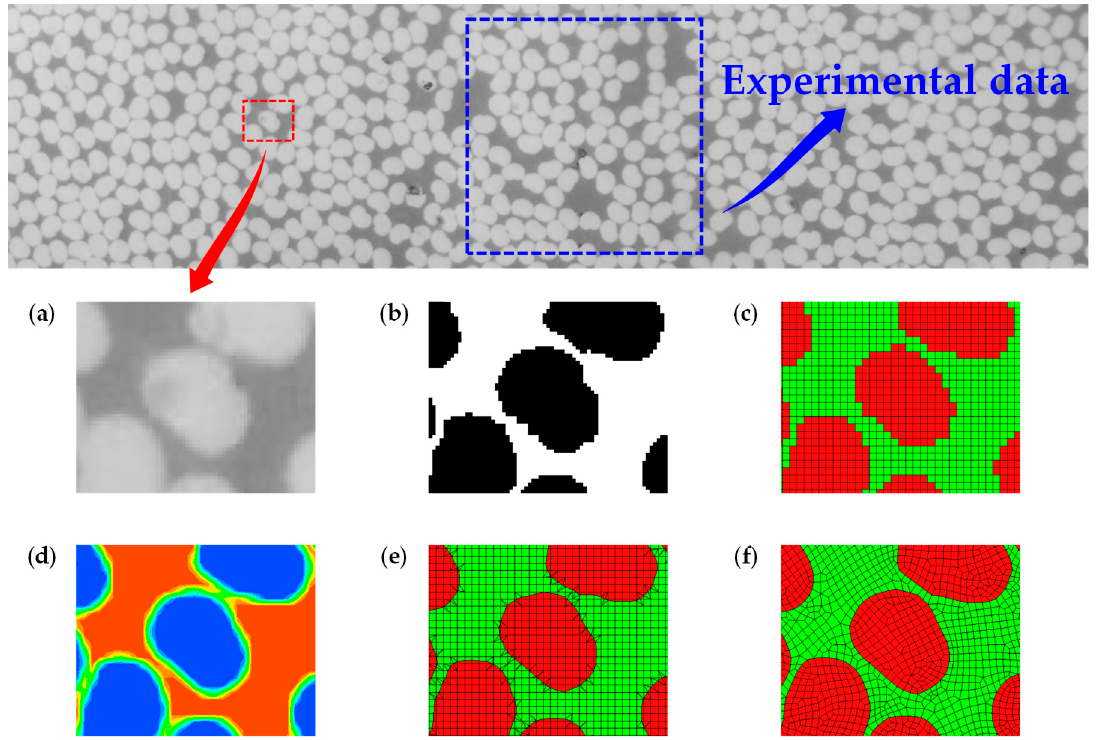
Figure 1. Procedure of generating FE model from a microscopic image of M55J/M18 composite: ( a ) original image, ( b ) binary image, ( c ) voxel mesh with image rescaling, ( d ) minimum SDF, ( e ) trimmed mesh, and ( f ) remeshing to quadrilateral elements.